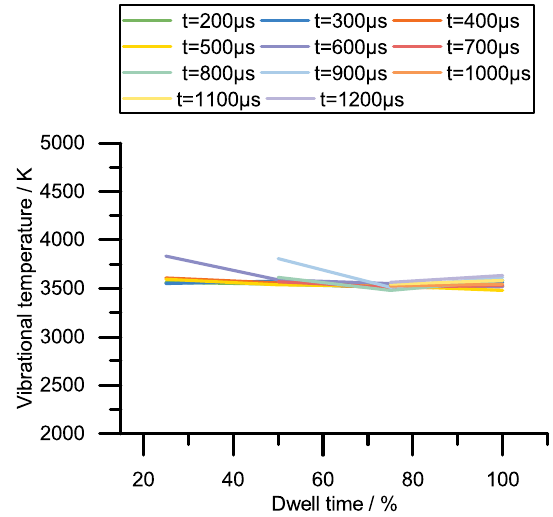
Fig. 10 Vibrational temperatures of different time intervals in the negative glow depending on the dwell time of the ignition